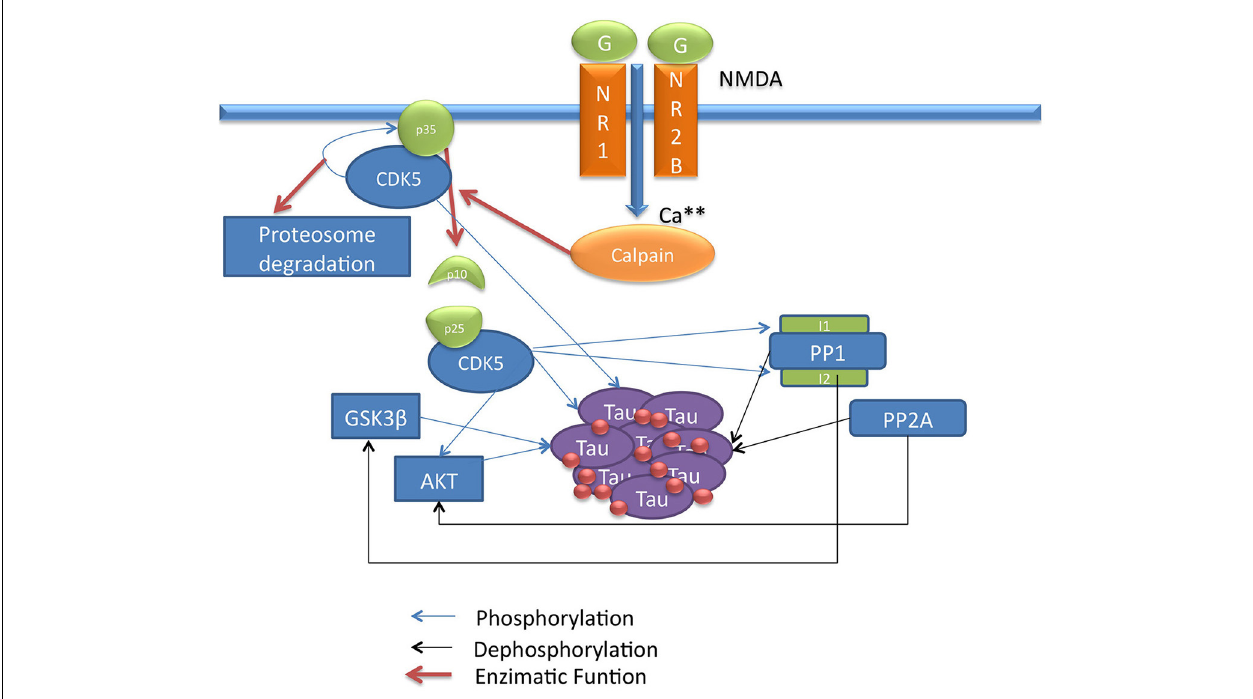
FIGURE 1 | Scheme of CDK5 signaling pathway involved in Tau phosphorylation. This draw shows the CDK5 signaling pathway describing direct and indirect Tau phosphorylation by CDK5.